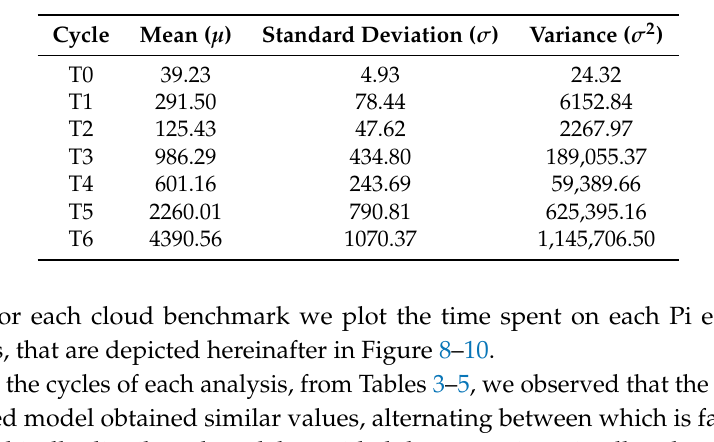
Table 5. Geographically distributed cloud server results (seconds).